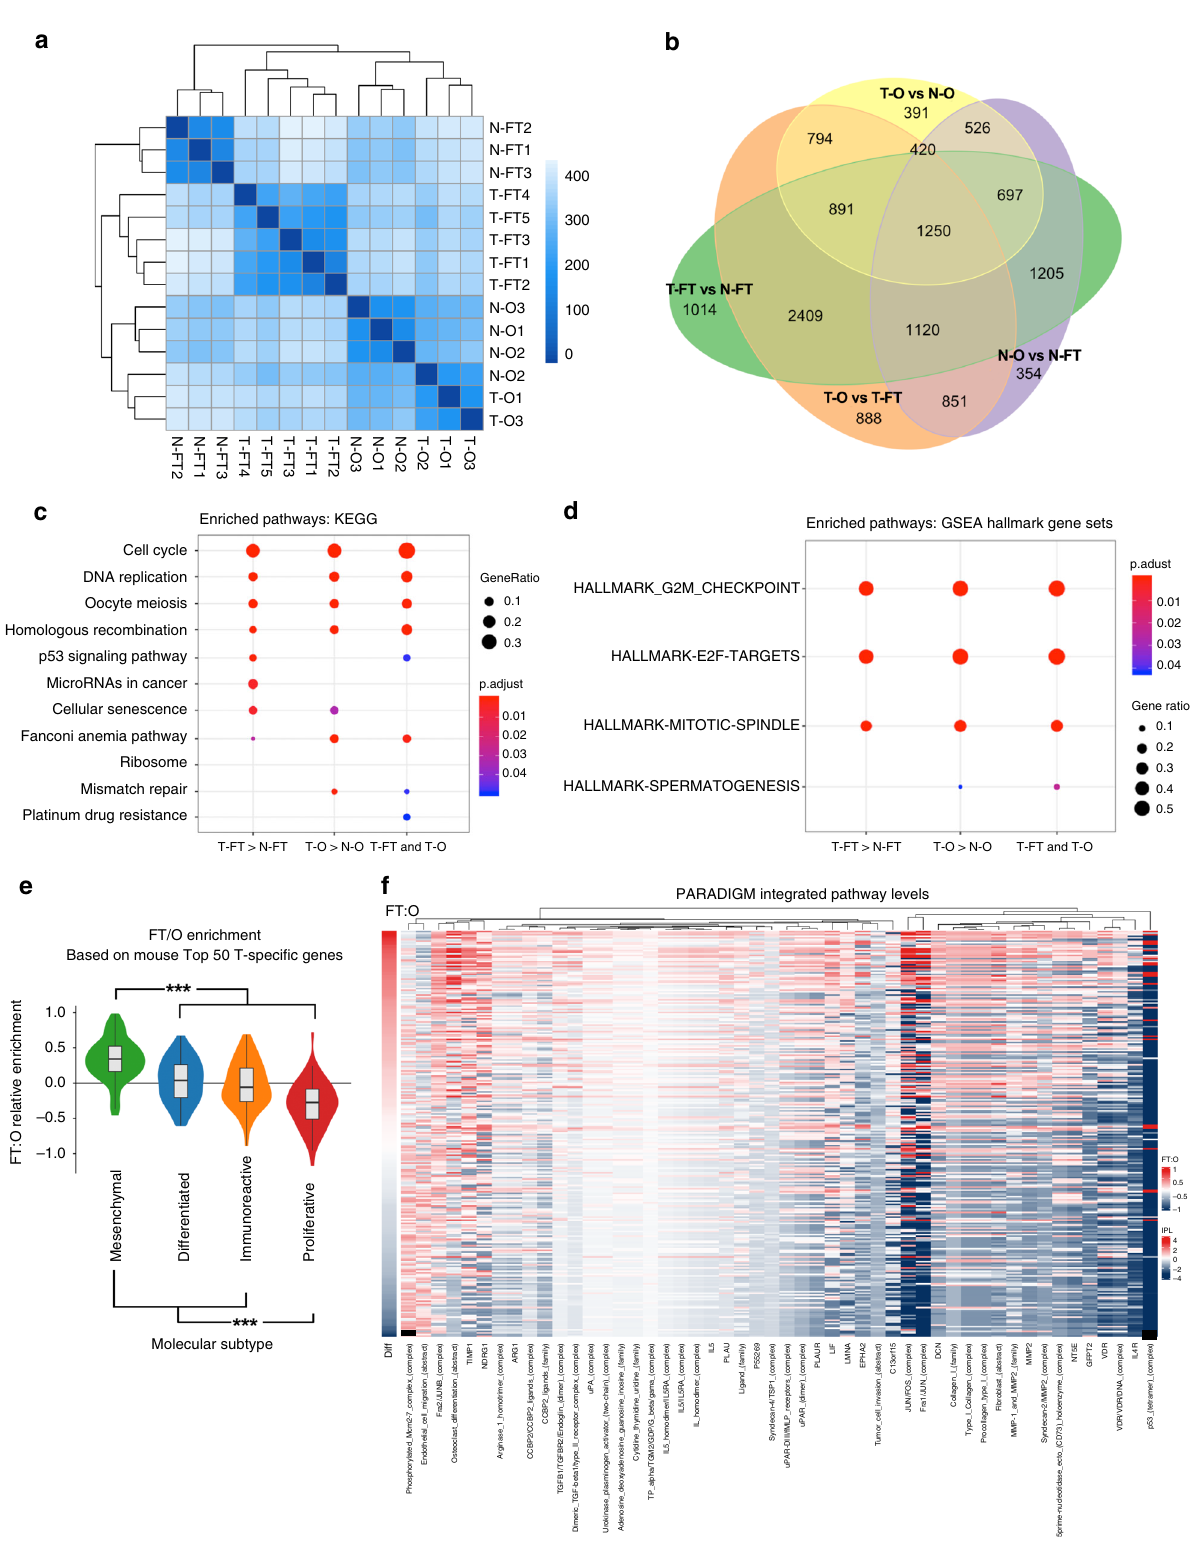
− 15 ), Ltf (log − 6.85, P = − 5.43; P = 3.24 × 10 − 6 ; adj < 10 2 FC adj log 2 FC = − 8.72, P adj < 10 − 15 ), Slc34a2 (log 2 FC = − 4.4, P adj = 1.8 × 10 − 4 ; log 2 FC = − 4.84, P adj = 2.7 × 10 − 6 ), were highly expressed in N-FT and T-FT, compared with N-O and T-O. By